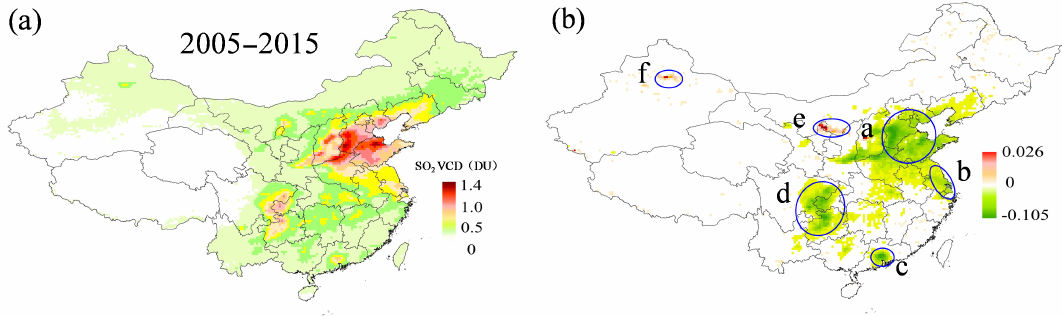
Figure 4. Annual averaging OMI-retrieved vertical column densities of SO 2 (DU) and their trends from 2005 to 2015 on 0.25 (cid:48) × 0.25 (cid:48) latitude–longitude resolution in China. (a) Annual mean SO 2 vertical column densities; (b) slope (trend) of linear regression relationship between annual averaging OMI-retrieved SO 2 VCD and the time sequence from 2005 to 2015 over China. The positive values indicate an increasing trend of SO 2 VCD from 2005 to 2015, and vice versa. The blue circle highlights the six selected regions including NCP (a) , YRD (b) , PRD (c) , Sichuan Basin (d) , Energy Golden Triangle (EGT, e ), and Ürümqi–Midong region (f)